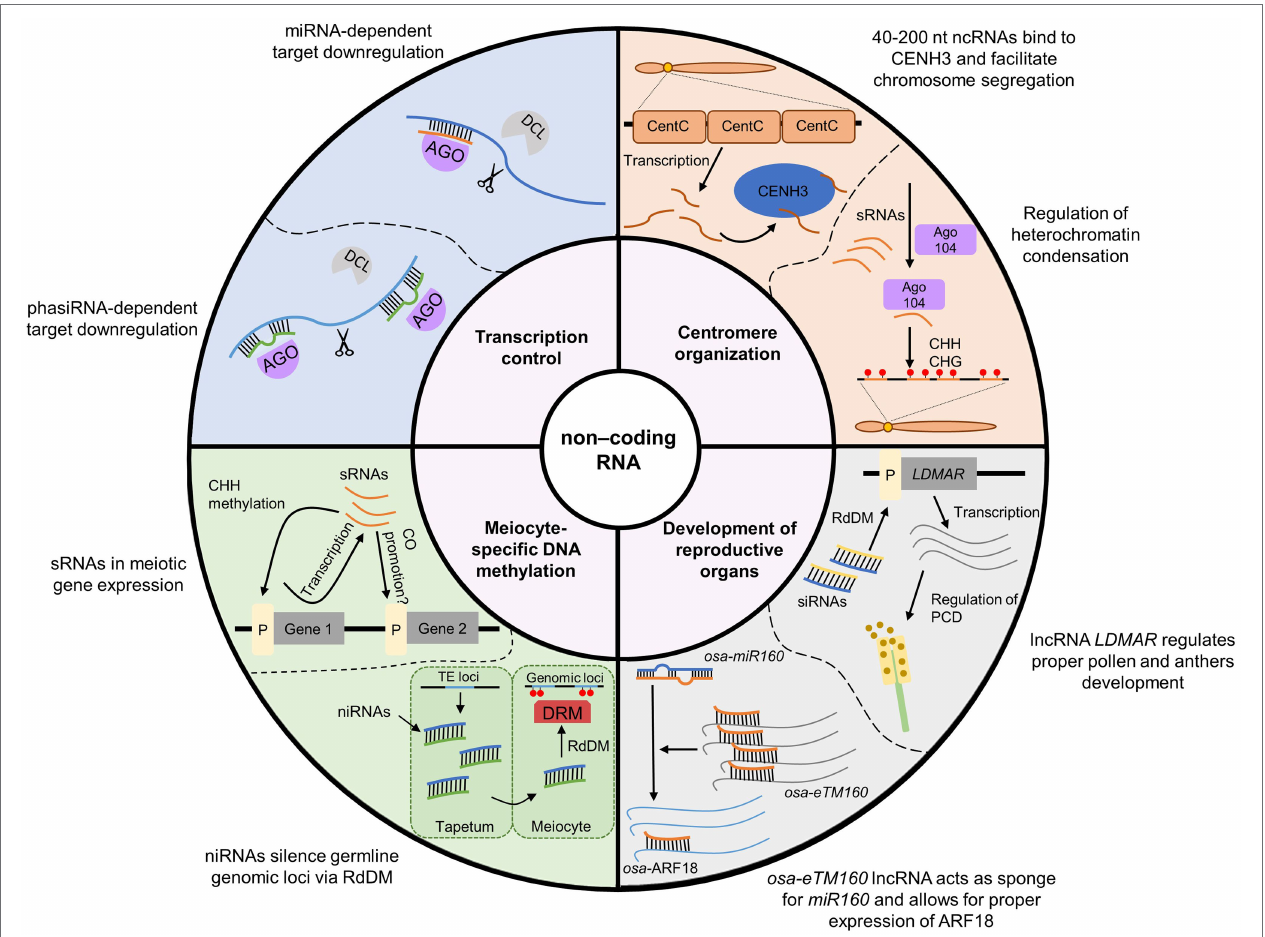
FIGURE 3 | Summary of the most important functions of ncRNAs in meiosis in plants. For the sake of simplicity, only the most characteristic examples of individual processes are presented. A more detailed explanation is provided in Table 1